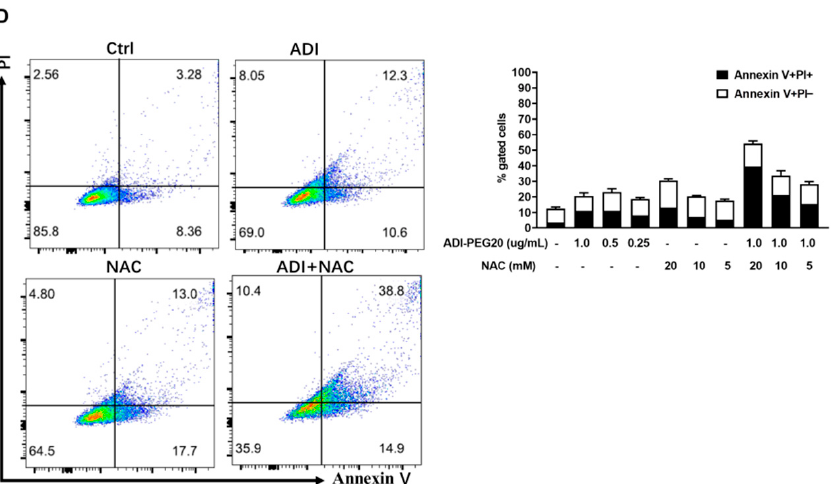
Figure 1. Apoptosis induction by ADI-PEG 20 and NAC. A summary of early (Annexin+/PI − ) and late (Annexin+/PI+) apoptotic cell death after 24 h ( A ) and 48 h ( B ) of treatment of MC38 cells and MDA-MB-231 cells for 24 h ( C ) and 48 h ( D ). The x -axis represents Annexin V-FITC staining, and the y -axis represents PI staining. Each experiment was conducted in triplicate. Ctrl: no treatment control; PI: propidium iodide.